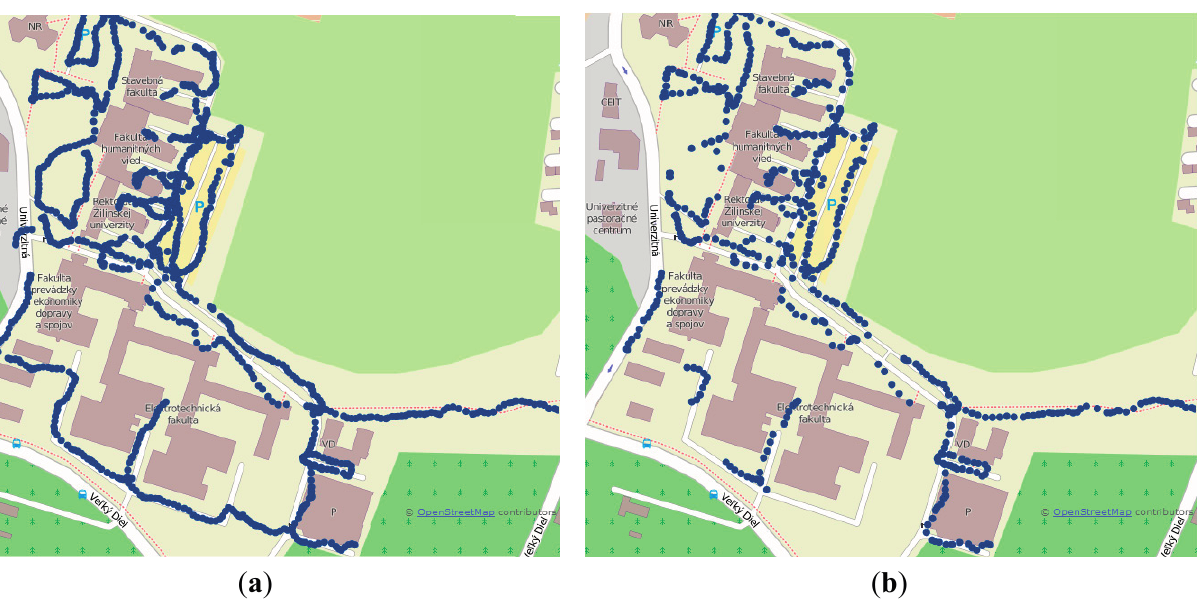
Figure 8. Outdoor radio maps for ( a ) GSM and ( b ) Wi-Fi displayed on Open Street